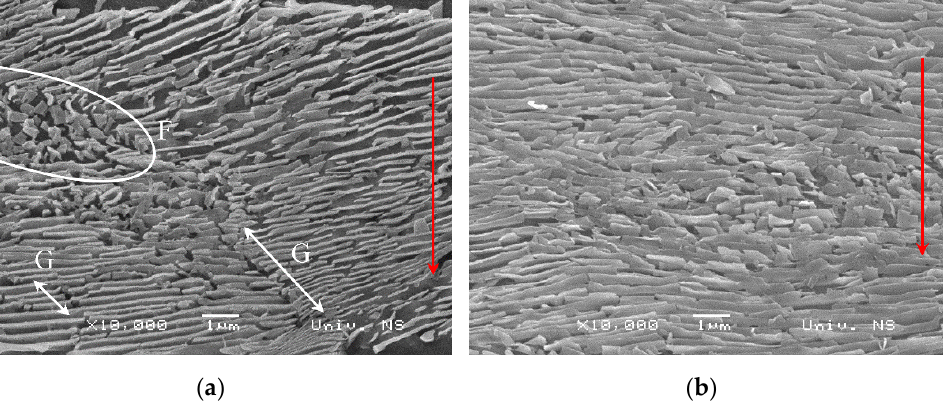
Figure 16. Microstructure of specimen in Zone I ( a ) and Zone IV ( b ) for strain level ε z 2 = 0.75 (red arrow—direction of upsetting).